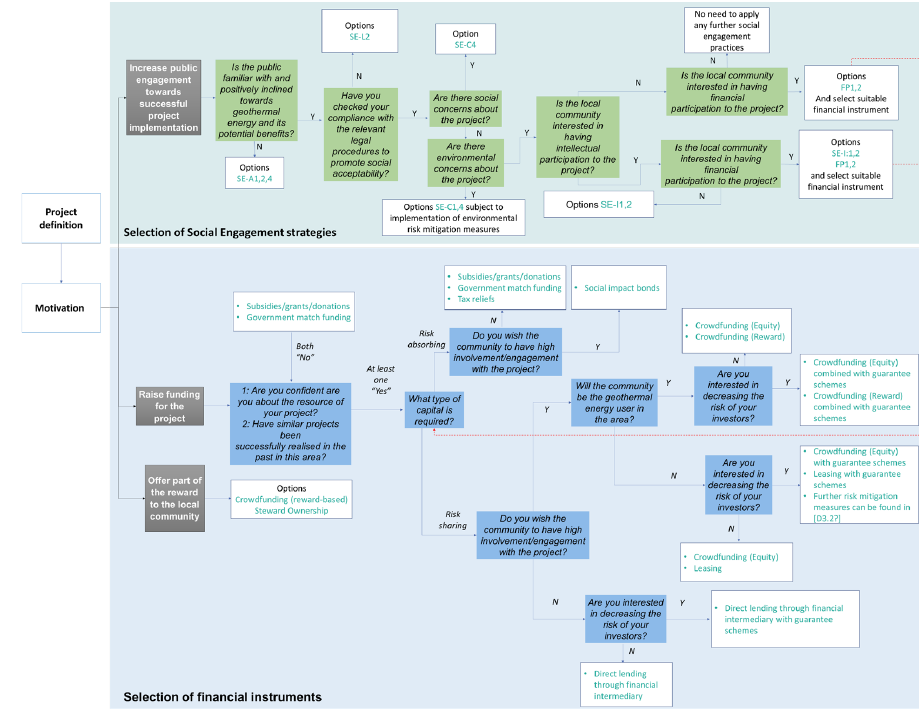
Figure 4. DT—Project definition phase .